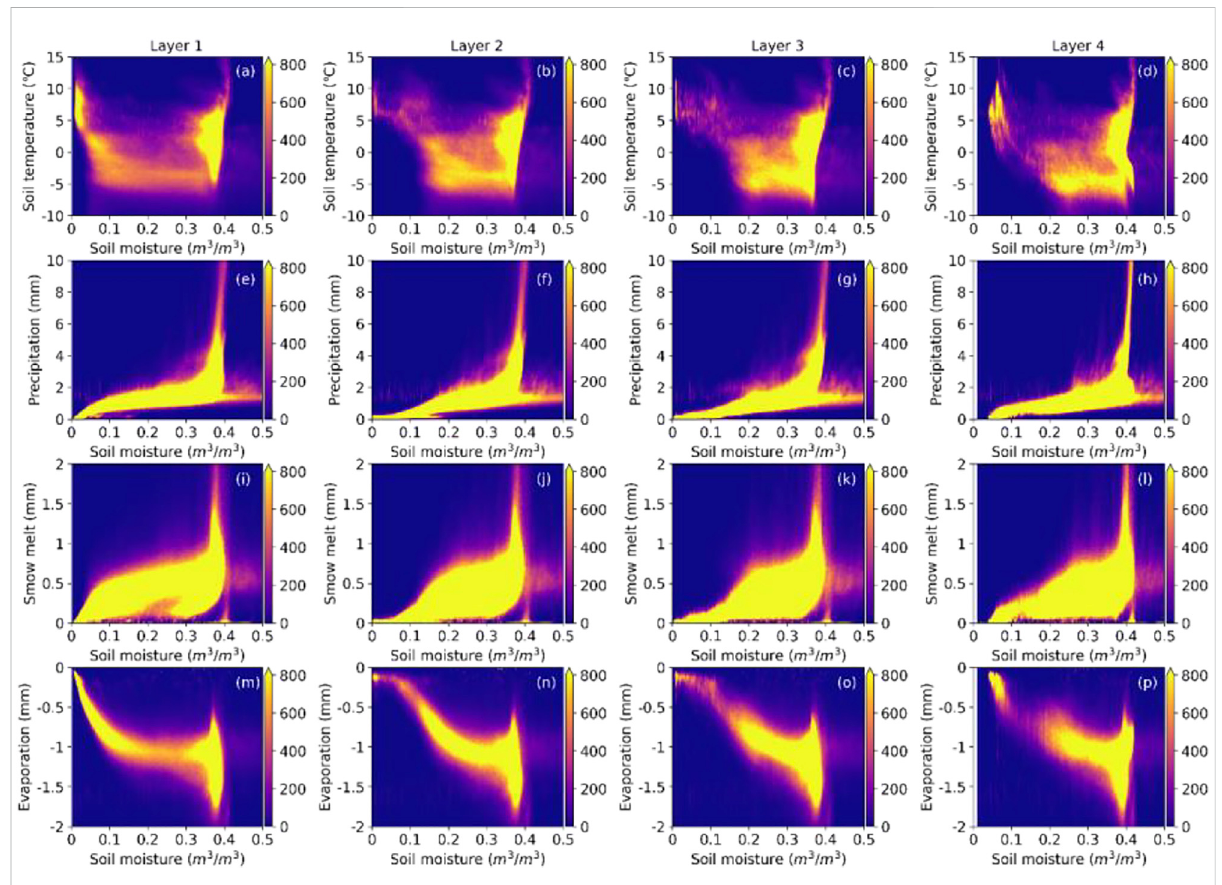
FIGURE 10 Scatterdensity mapbetweensoiltemperature,precipitation,snowmelt,evaporation,andsoilmoisture inlayer1 (A , E , I , M) ,layer2 (B , F , J , N) ,layer 3 (C , G , K , O) , and layer 4 (D , H , L , P)